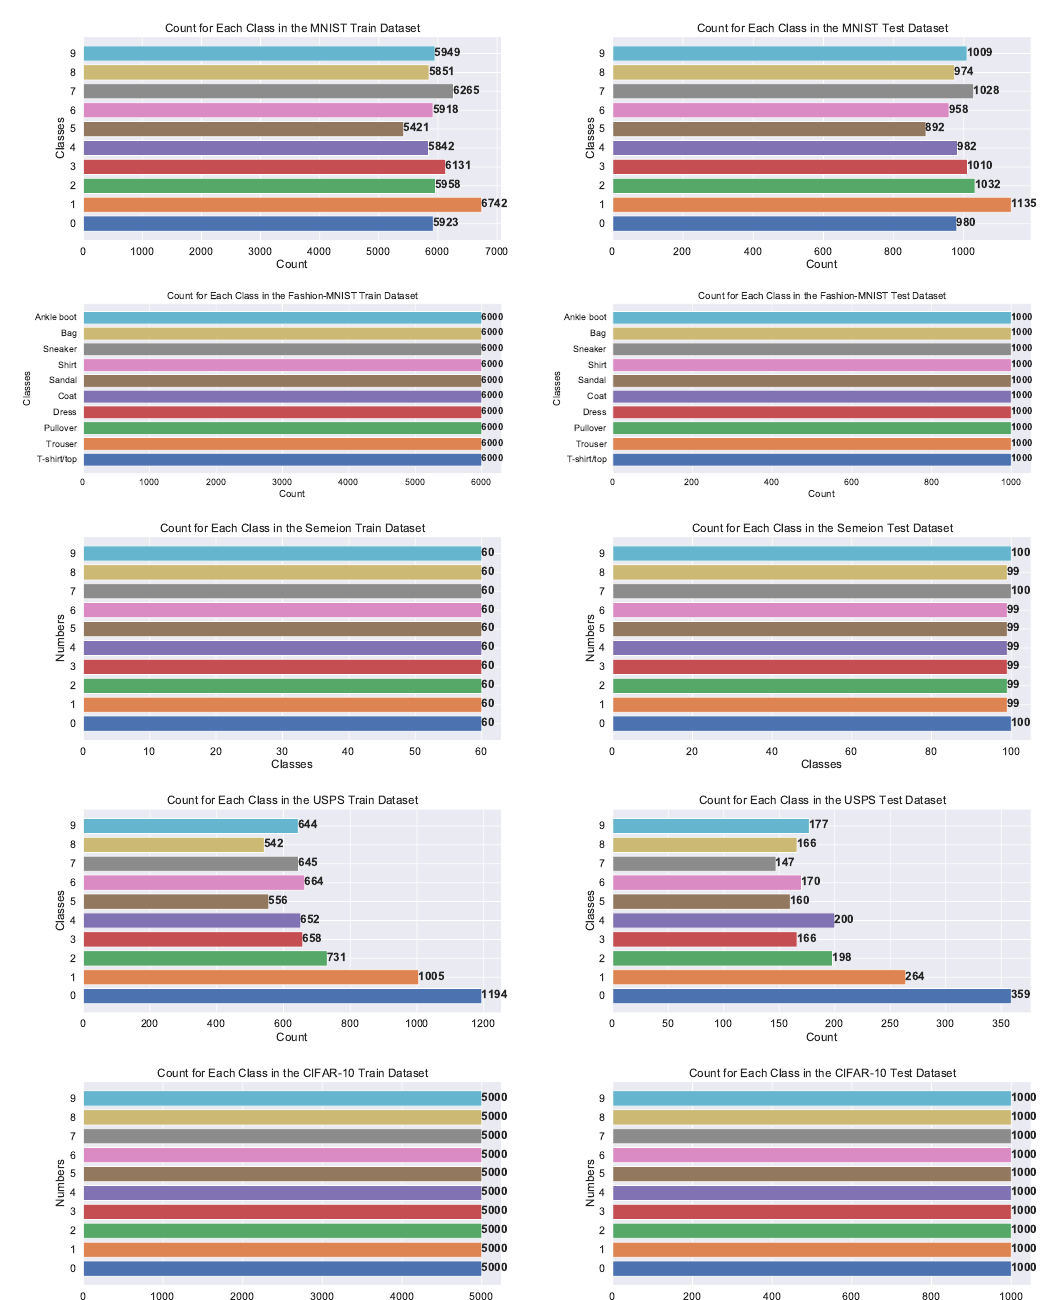
Figure 5. Number of instances per each class in the training and testing sets for MNIST, Fashion-MNIST, Semeion, USPS, and CIFAR-10